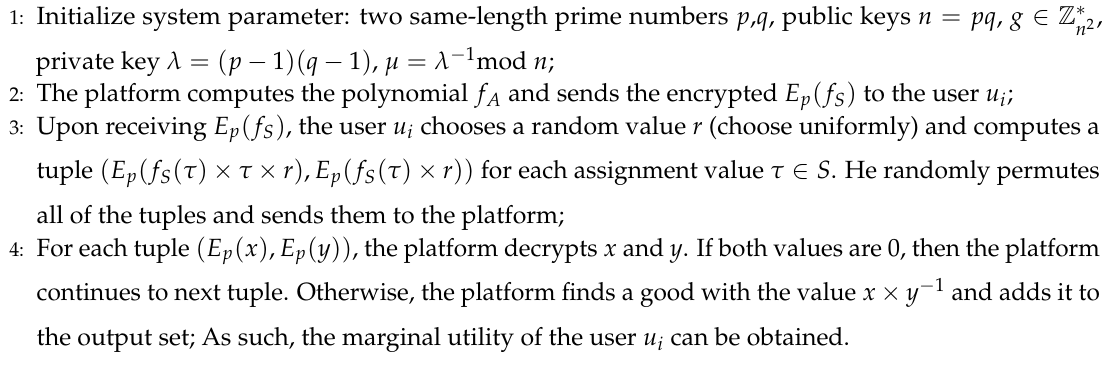
Algorithm 3 Privacy-Preserving set Union